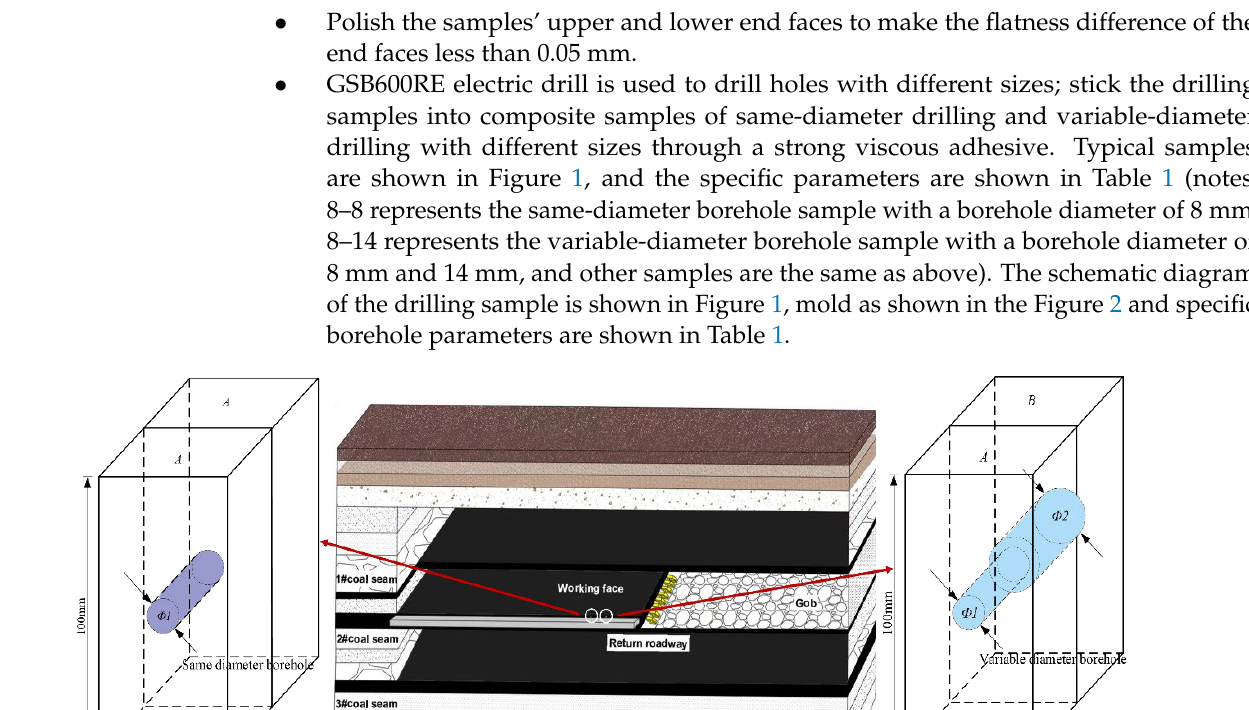
Table 1. Experimental design.